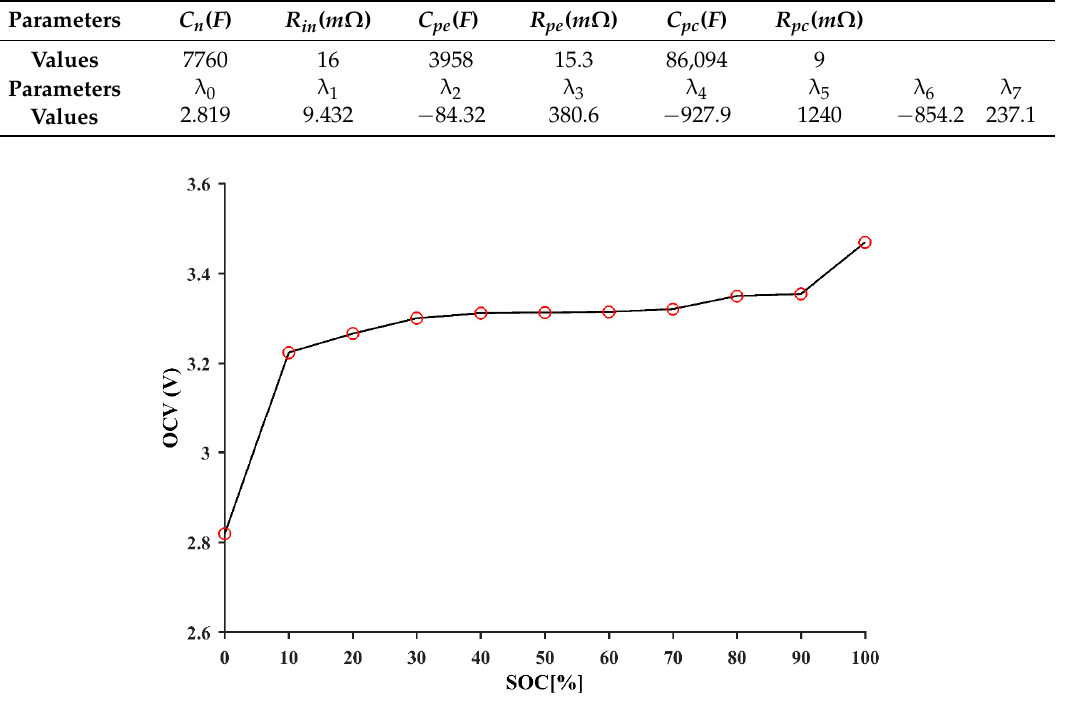
Figure 5. OCV-SOC relationship for a LiFePO 4 battery from a PCC test.